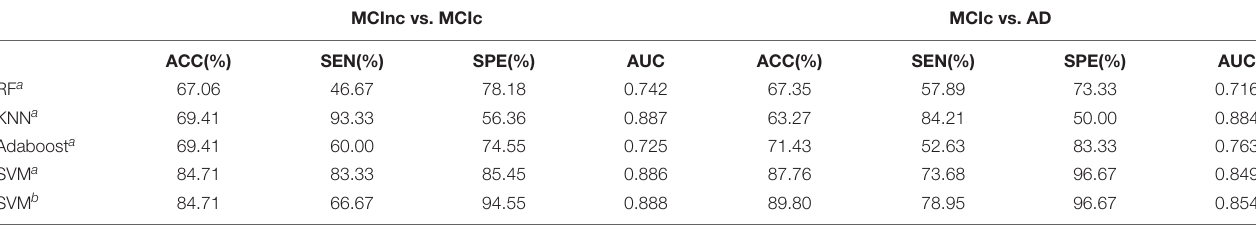
TABLE 4 | Classification performance of multiple classifiers based on RSFS algorithm using the top 10 features. MCInc vs. MCIc MCIc vs. AD